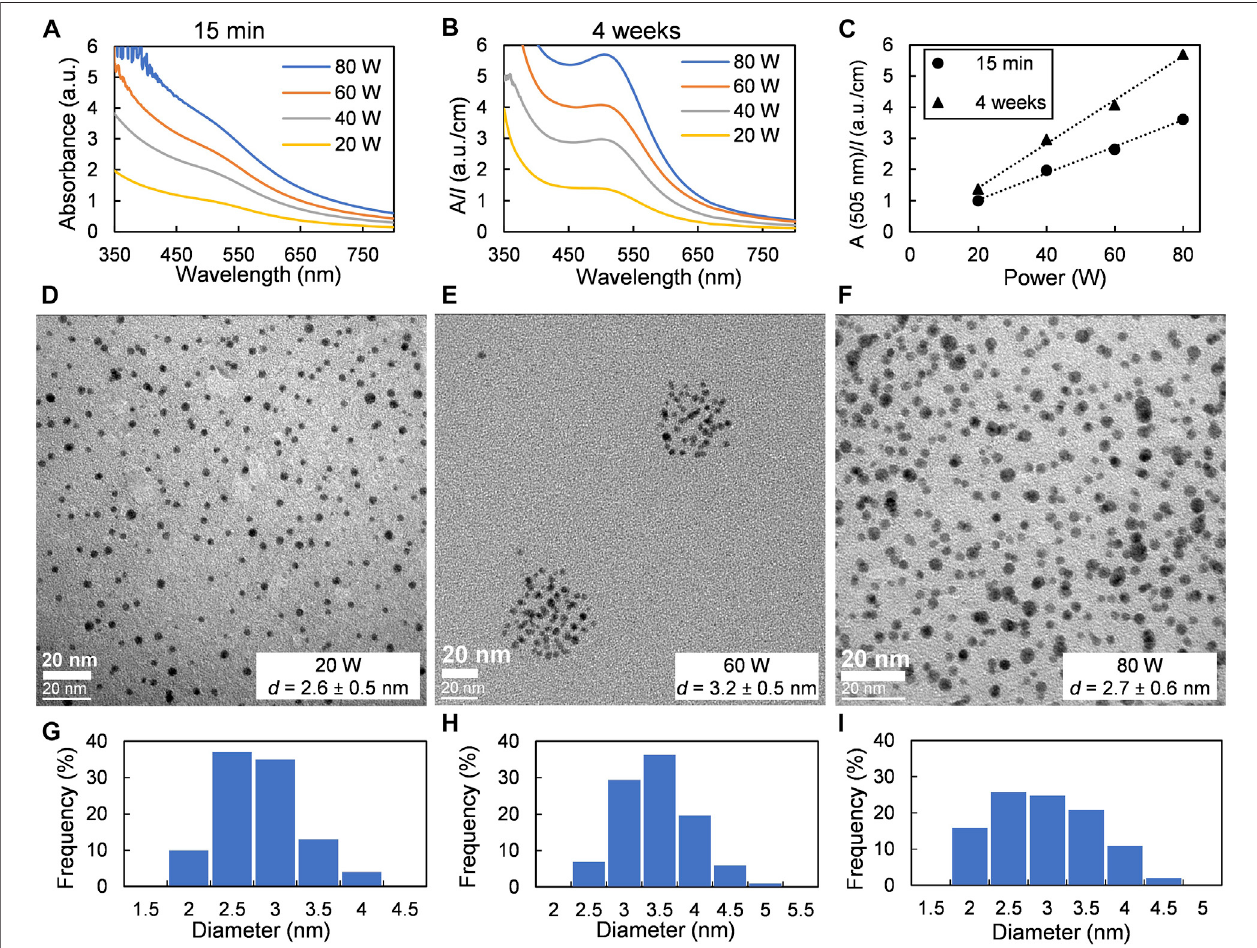
FIGURE 3 | Effect of applied power: samples were obtained at a fi xed argon pressure of 0.07 Pa and a sputter time of 10 min. (A) and (B) UV-vis spectra of dispersions of Au NPs in castor oil recorded 15 min and 4 weeks after deposition, respectively. (C) Changes in absorbance at the maximum of SPR band of Au NPs. (D – F) TEM images and (G – I) size distributions of Au NPs obtained at sputter power of 20, 60, and 80 W, respectively.